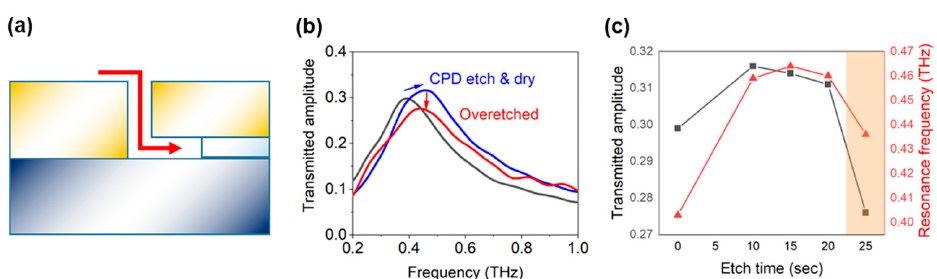
Figure 5. ( a ) Schematic of an over-etched sample. As there is a layer of alumina not only between but also beneath the metallic layers, etching for a longer time leads to undermining of the whole structure and partial collapsing of the nano-trenches. Note that the figure is not in scale and the vertically aligned portion of the dielectric (250 nm) is much smaller than that of the underlying layer (10 μ m). ( b ) Spectra of the nano-trenches fabricated with proper wet etching time (blue line) and longer etching time (red line). ( c ) Transmitted amplitude and frequency at the resonance of the nano-trenches, fabricated with different etching times. Wet etching time of longer than 25 s leads to partial collapsing of the structure (shaded area).